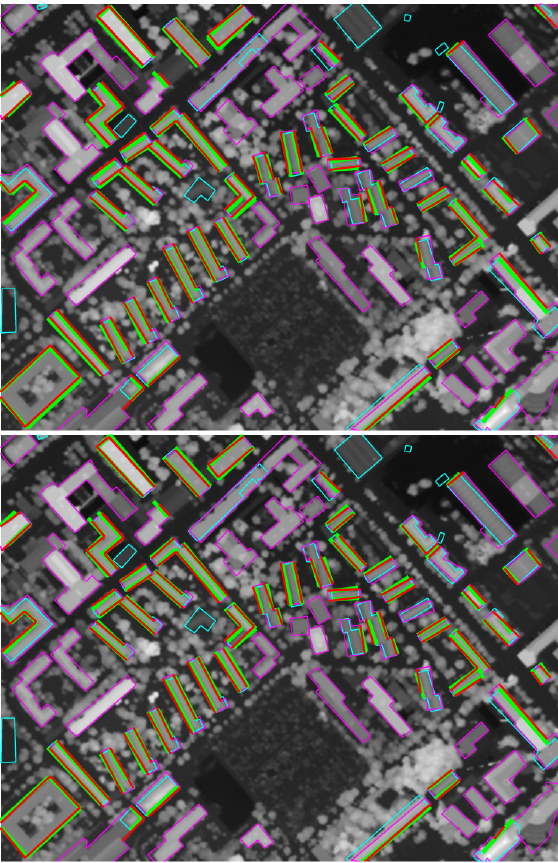
Figure 6: Detected lines in 3K DSM and HSI, before (top) and after coregistration (bottom). Line colours are analogue to de- scription under Fig.